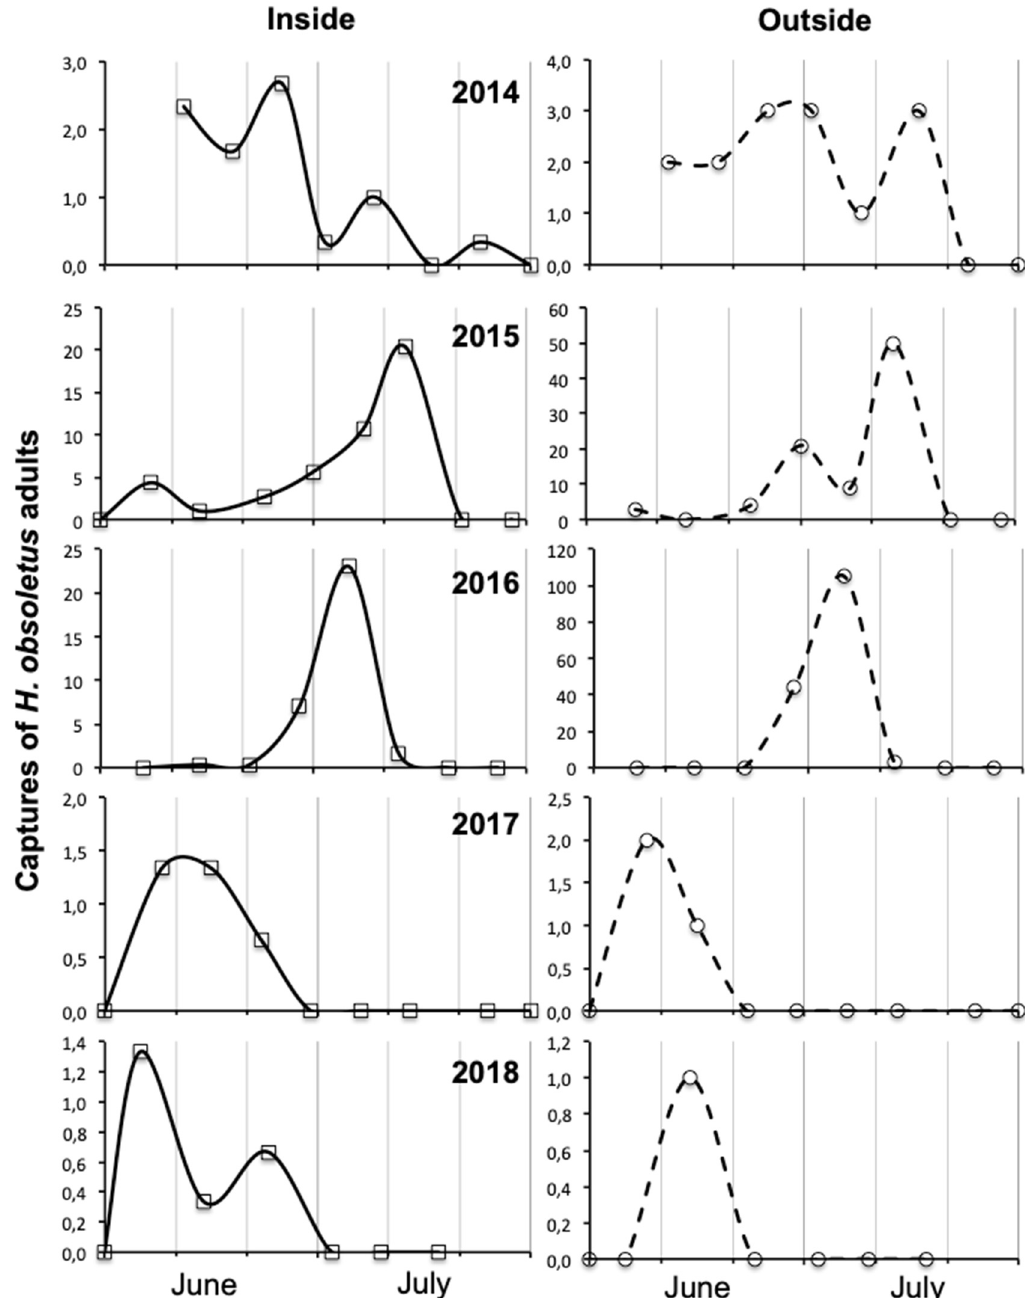
Figure 4. Hyalesthes obsoletus captured on yellow sticky traps during 2014–2018 both inside and outside vineyard B. A value of outside captures refers to the sum of seven traps and that of inside to the sum of the average of each of seven series.